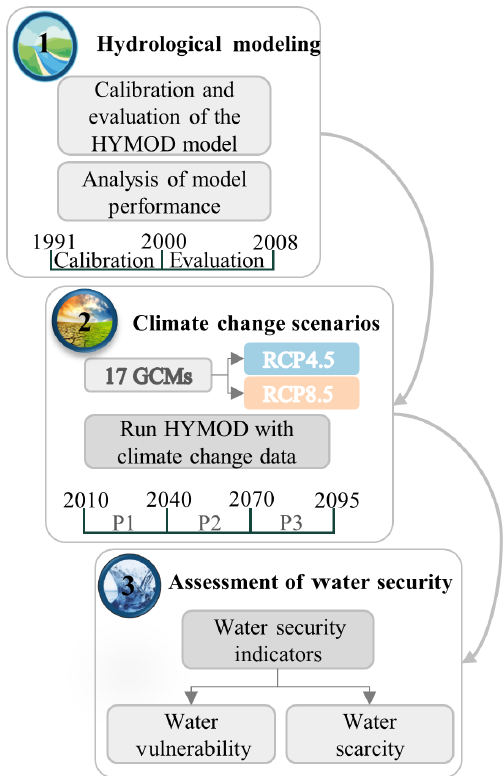
Figure 2. Study delineation. RCP denotes Representative Concen- tration Pathway and GCM represents global circulation models; P1 refers to the immediate future (2010–2040), P2 refers to intermedi- ate future (2041–2070) and P3 refers to distant future